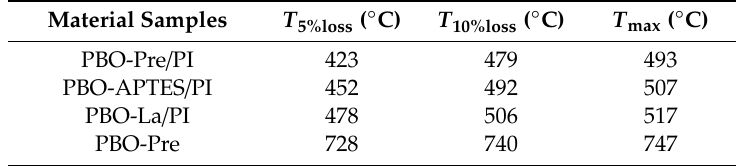
Table 1. Characteristic decomposition temperatures of the PBO-Pre fiber and PI composites at different mass losses.